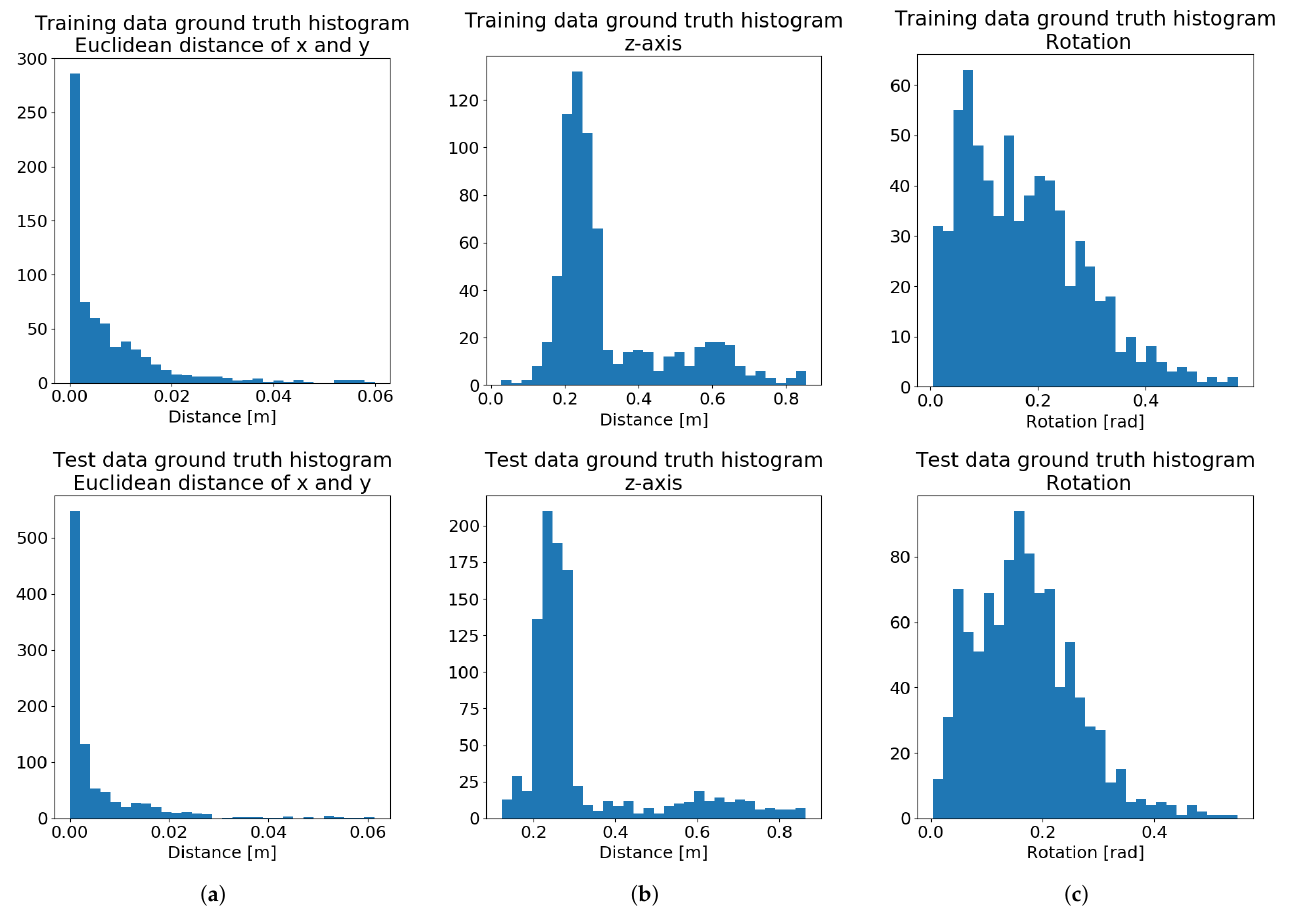
Figure 15. Training (top) and test (bottom) data distribution depicting: ( a ) Deviations in the x and y axes. ( b ) The distance from the object. ( c ) Orientation deviations.